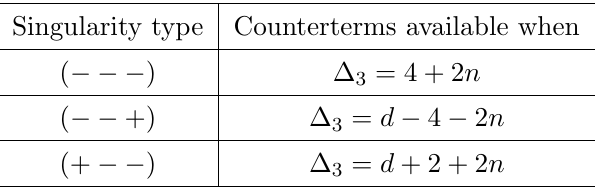
Table 6 . Availability of counterterms for h J (cid:22) 1 J (cid:22) 2 O I i